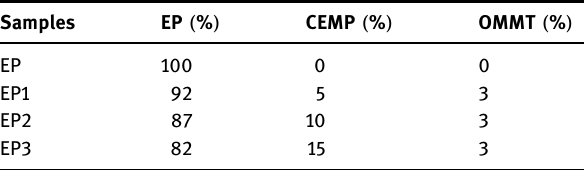
Table 1: Mass ratio of each component